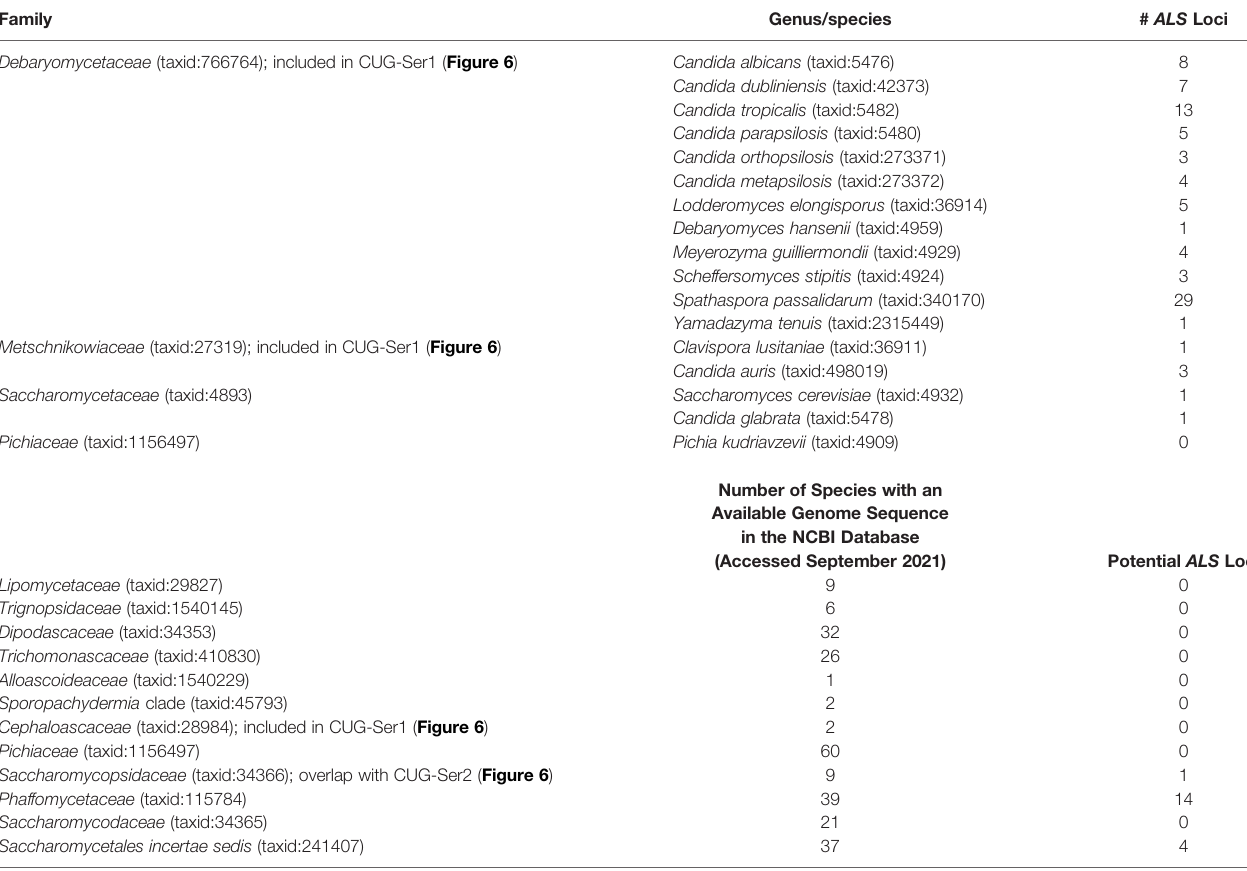
TABLE 4 | ALS gene representation within the Order Saccharomycetales*.